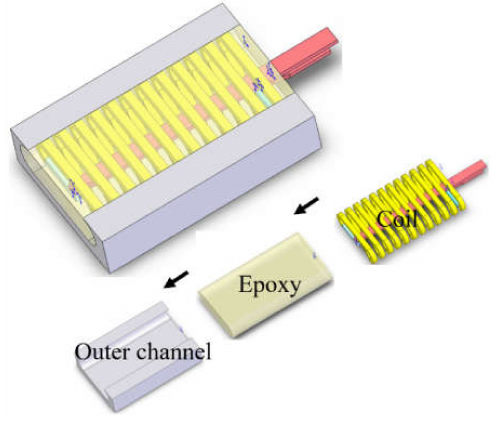
Figure 3. A three-dimensional model of the uniform pressure actuator.